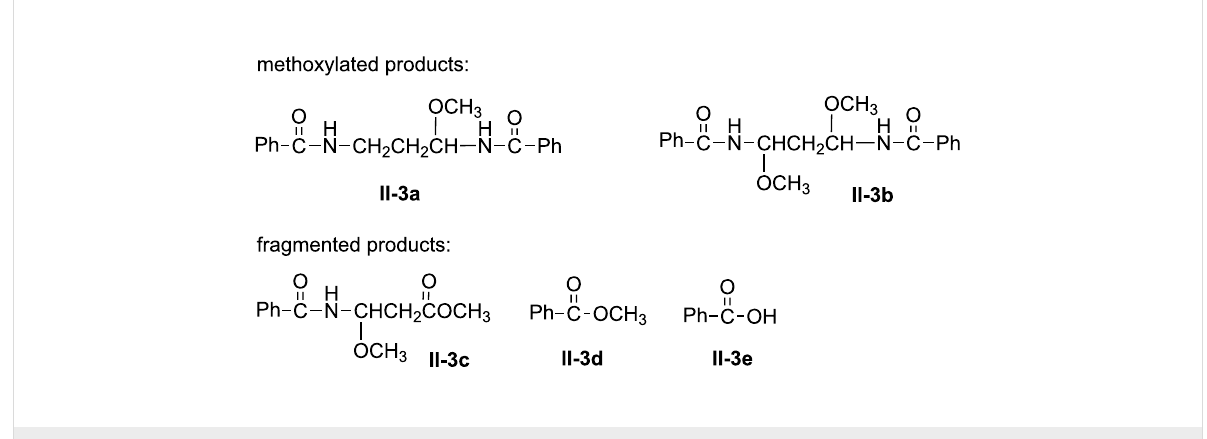
Scheme 8: Type of products obtained from anodic oxidation of II - 3 .